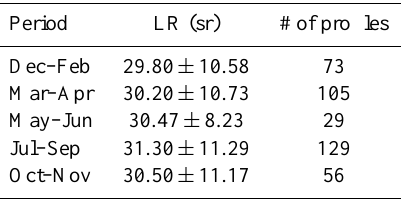
Table 3. Lidar ratios (LR) at SCO station when AE ≤ 0 . 75, for dif- ferent periods during